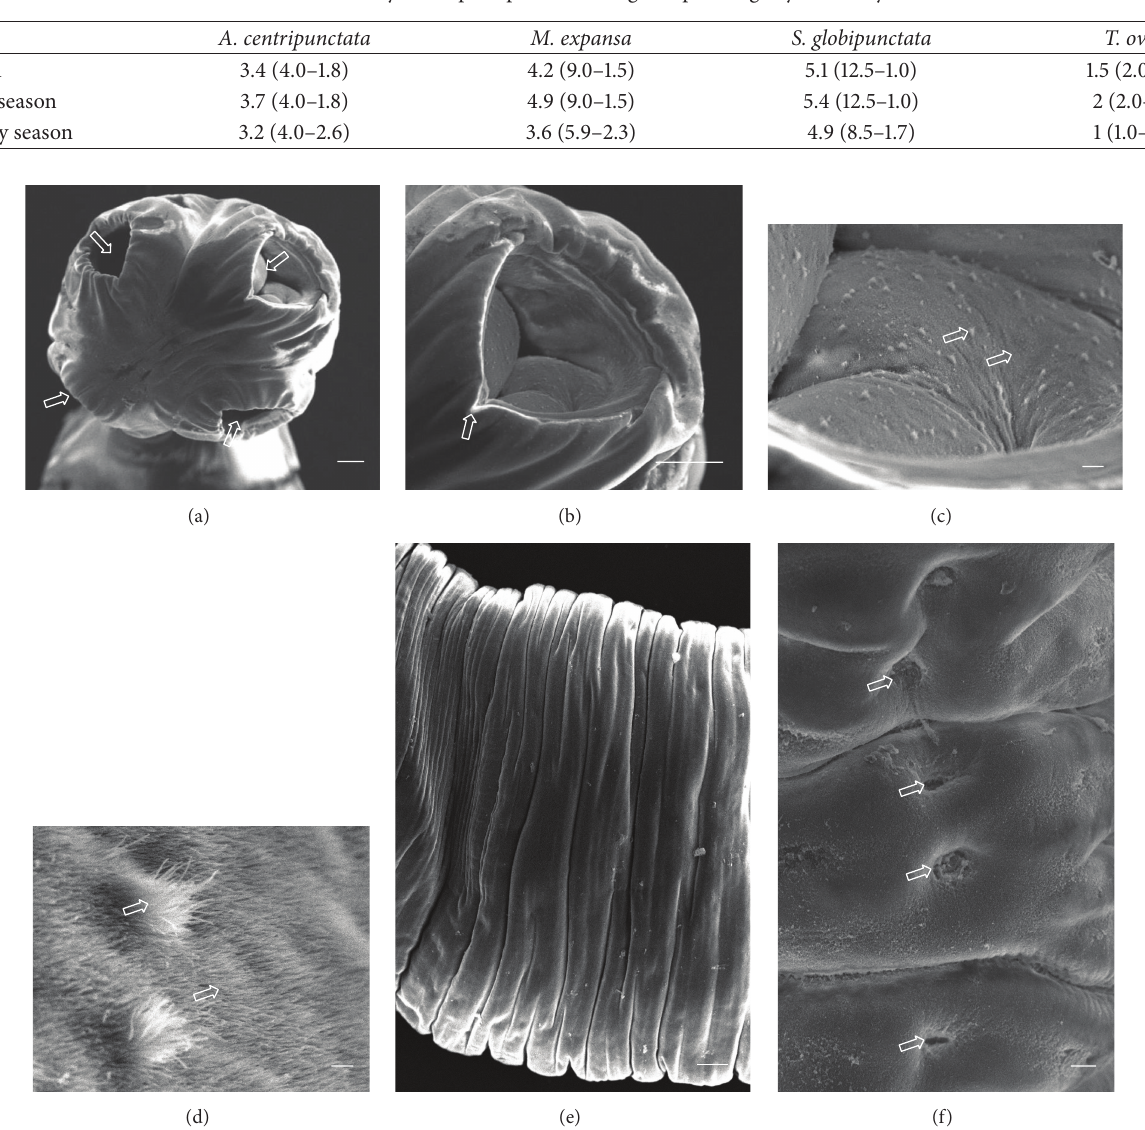
Figure 3: (a)–(f) Scanning electron micrographs of Avitellina centripunctata . (a) General anterior view of scolex, arrows show invaginated suckers. (b) Invaginated sucker, arrow showing triangular opening. (c) Peripheral sucker, arrows show acicular and capilliform filitriches (Scale bar, 10 𝜇 m). (d) Acicular and capilliform filitriches covering sucker (scale bar, 1 𝜇 m). (e) Portion of strobila showing acraspedote proglottids. (f) Lateral portion of strobila, arrows show genital pores (Scale bar, 10 𝜇 m). Scale bar = 100 𝜇 m, unless stated